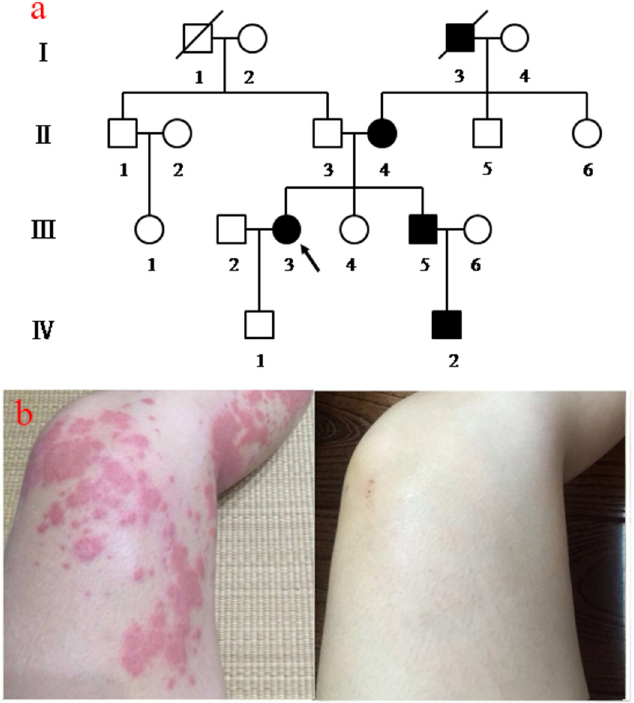
Fig 1. FCAS Pedigree and Photographs of Rashes. (a) FCAS pedigree and analysis. Squares and circles indicate males and females, respectively; black symbols and unfilled symbols indicate affected and unaffected individuals, respectively. The proband is indicated by an arrow. (b) Photographs of cold urticaria provoked after exposure to a 4°C outdoor atmosphere for 30 minutes and after being at room temperature with no rashes.